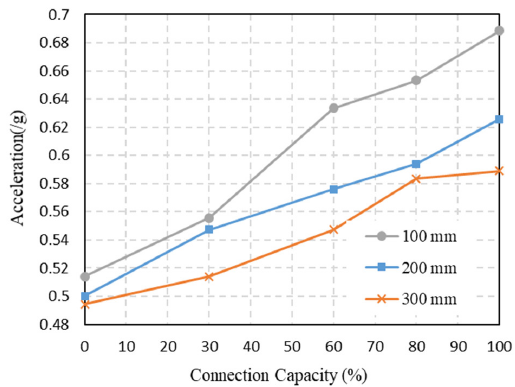
Figure 23. Peak acceleration of 5-story frames.